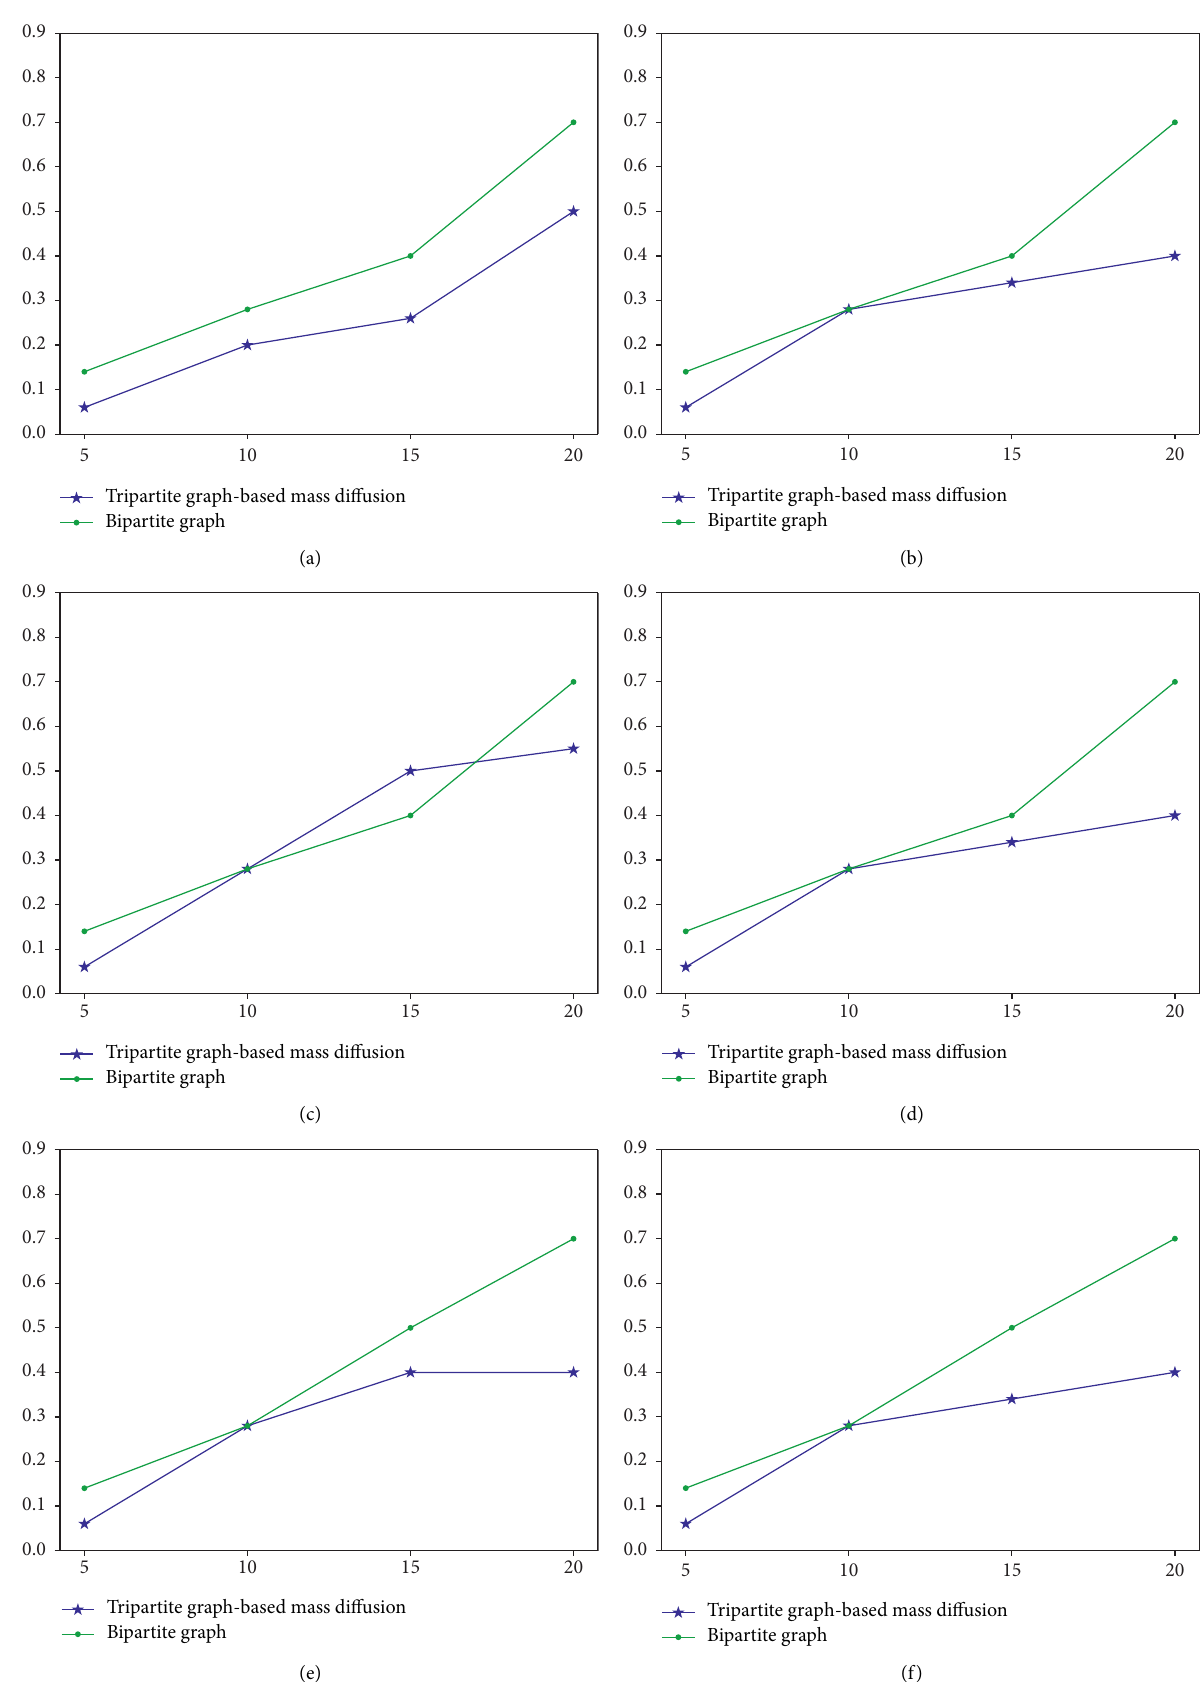
Figure 7: Recall of the hybrid model